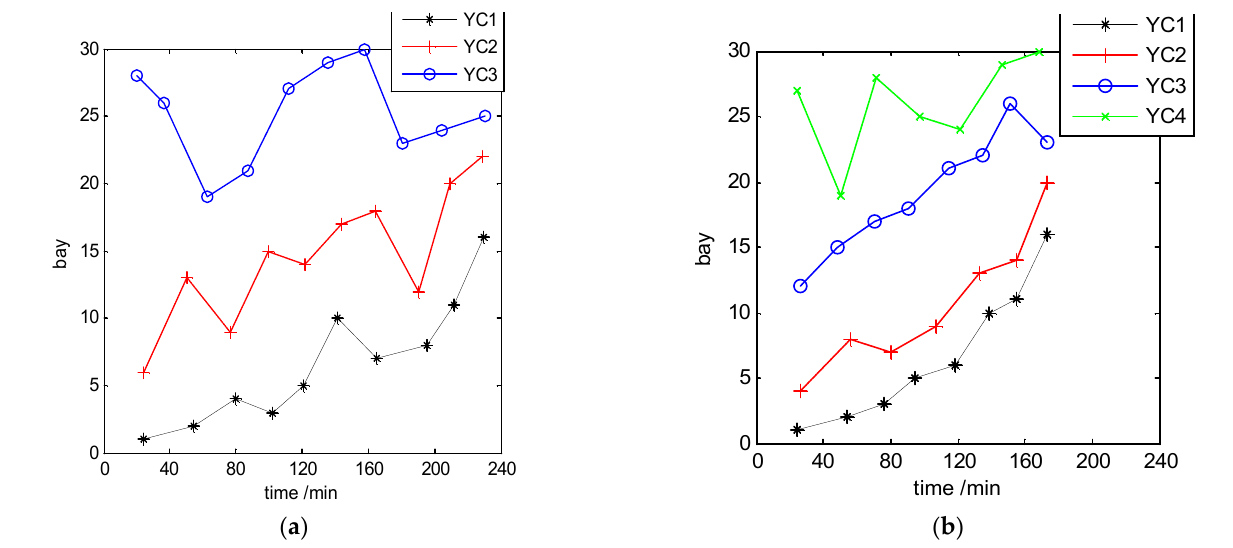
Figure 10. Multi-yard crane operational solutions. ( a ) Walking paths of three yard cranes; ( b ) walking paths of four yard cranes.